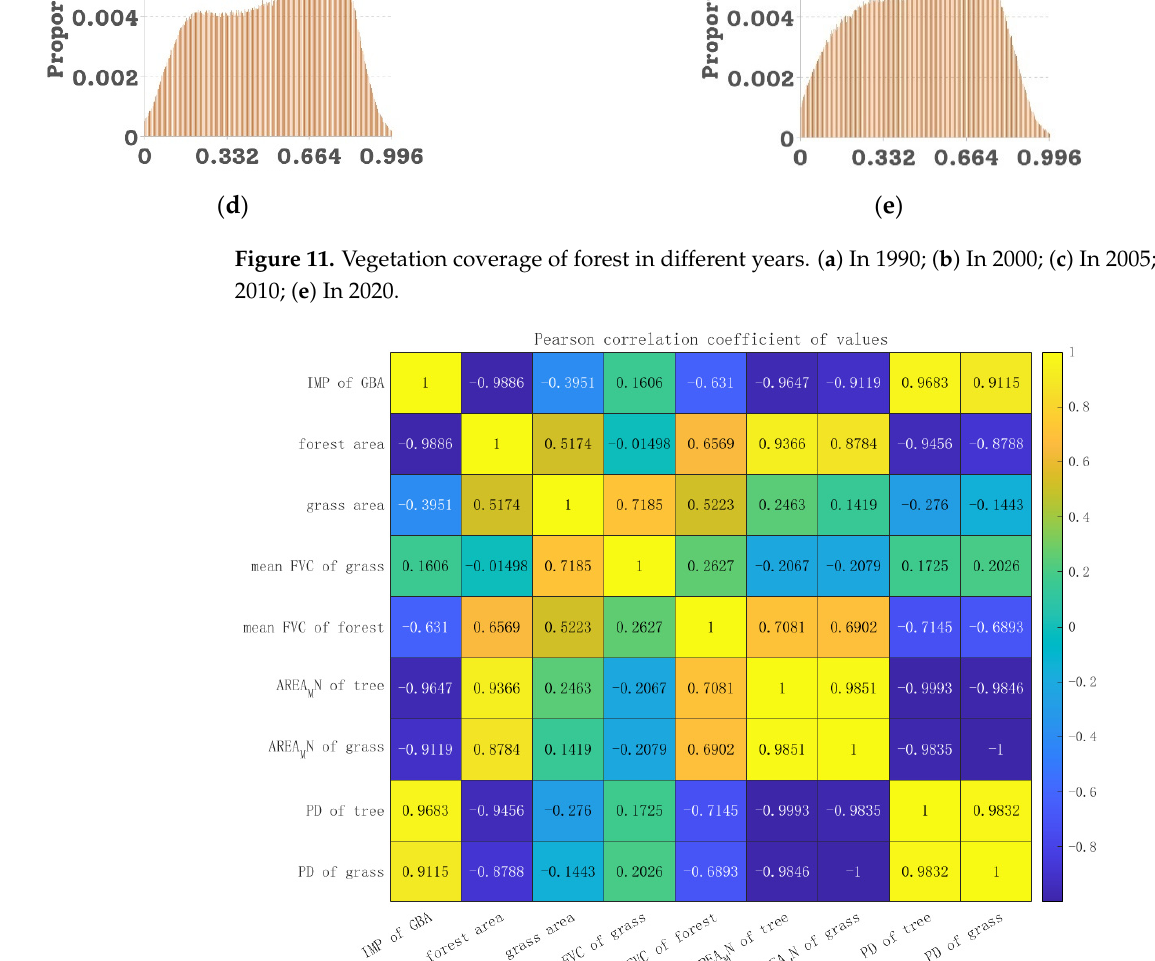
Figure 12. The correlation matrix.